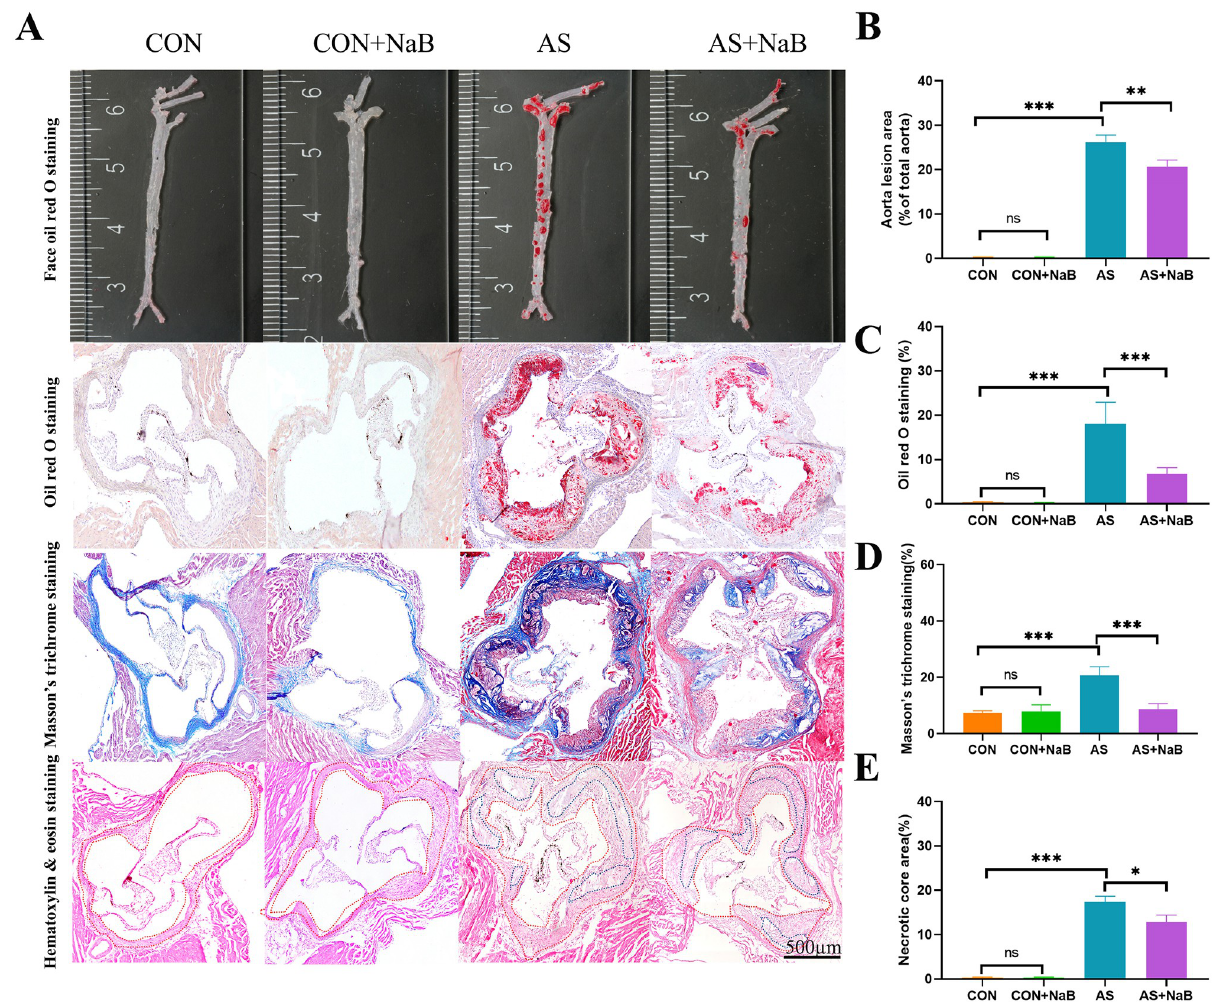
Fig 2. NaB consumption reduced aorta atherosclerosis. (A) Representative sections of the valve area of the aortic root of the heart were stained with en face oil red O staining, oil red O staining, Masson’s trichrome staining and hematoxylin&eosin staining, respectively, Quantitative analysis as lesion area/total area (%). (B) face oil red O staining. (C) oil red O staining. (D) Masson’s trichrome staining and (E) Relative necrotic core area expressed as percentage of the total plaque area. � P < 0.05, �� P < 0.01, ��� P < 0.001. ns, no significant difference. The bar of 500 μ m was presented in the right corner of (A).